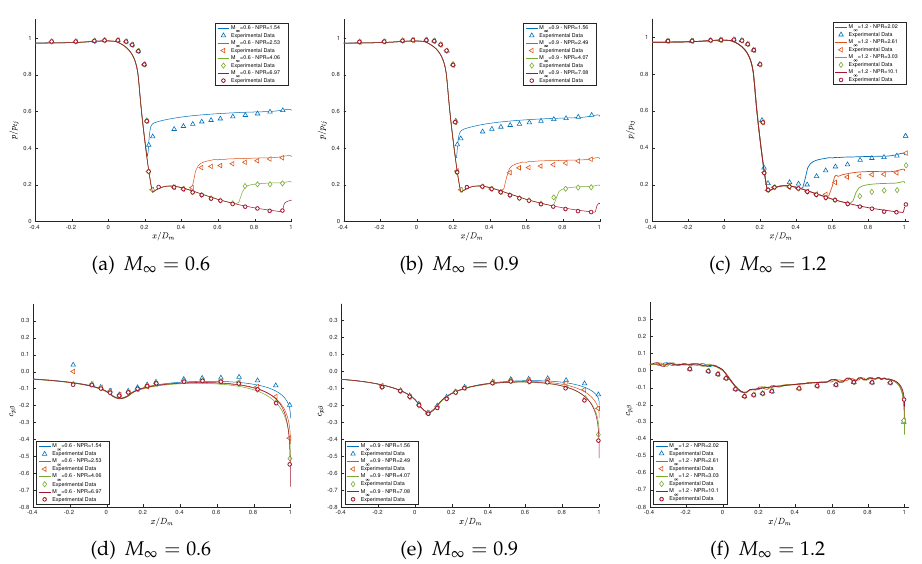
Figure 9. Internal nozzle walls static pressure distribution ( a – c ), and boat-tail pressure coefficient distribution ( d – f ). Comparison with experimental data.